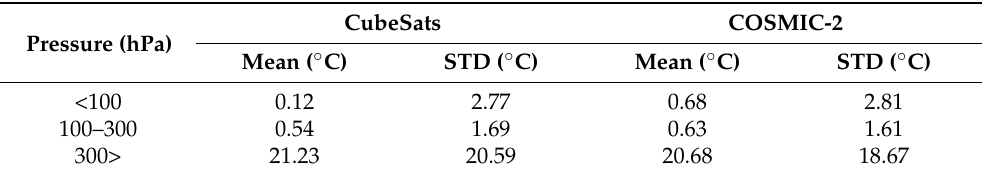
Table 9. Mean and standard deviation (STD) of the differences between CubeSats and COSMIC-2 temperature values and the radiosonde observations for different pressures